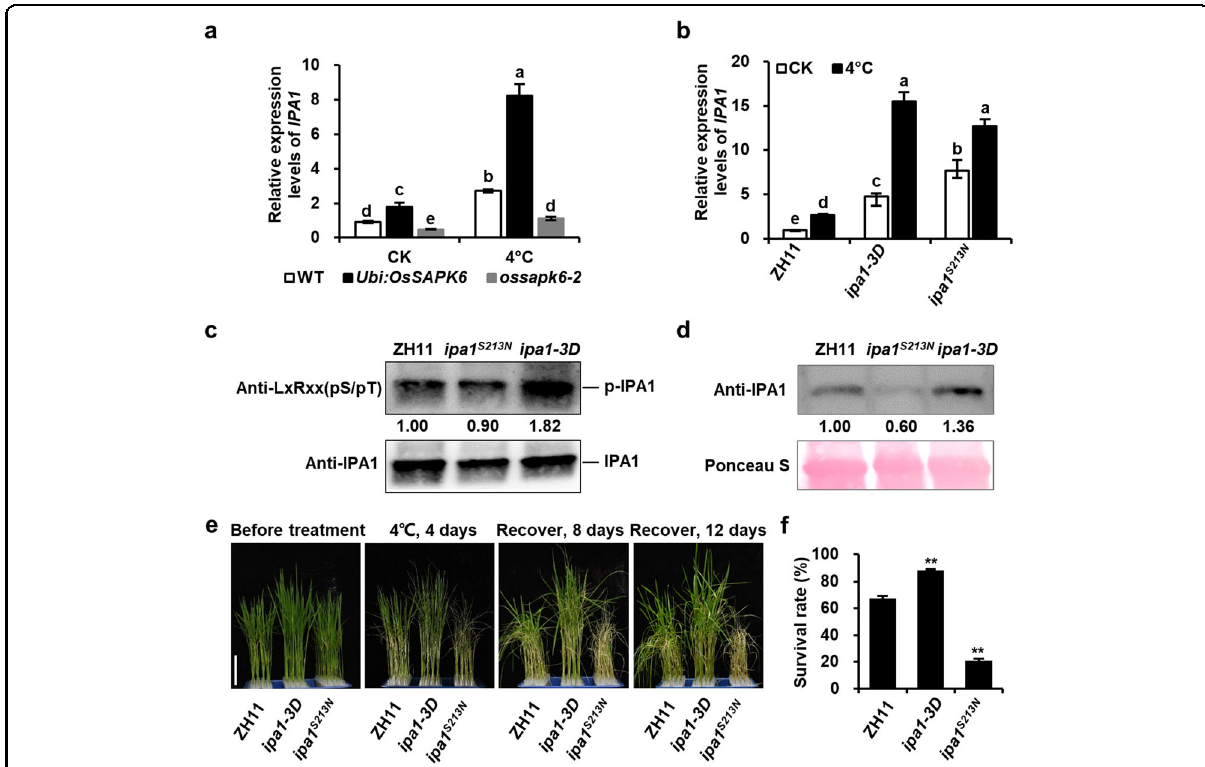
Fig. 5 Phosphorylation of IPA1 is critical for its function in chilling stress responses. a Expression levels of IPA1 in ZH11, Ubi:OsSAPK6 , and ossapk6-2 plants with or without 6 h 4 °C treatment. b IPA1 expression levels in ZH11, ipa1-3D and ipa1 S213N after 4 °C treatment for 6 h. c The phosphorylation of IPA1 in ZH11, ipa1-3D and ipa1 S213N . d IPA1 protein levels in ZH11, ipa1-3D and IPA1 S213N . e Plant morphologies of 2-week-old ZH11, ipa1-3D and ipa1 S213N seedlings before treatment, after 4 °C treatment for 4 days and subsequent recovery for 8 or 12 days. Bars = 5 cm. f Survival rates of ZH11, ipa1-3D and ipa1 S213N after 4 °C treatment as shown in e . Values are means ± SD ( n = 3 biological replicates). In a and b , the different letters indicate signi fi cant differences ( P < 0.01) according to Tukey ’ s honest signi fi cant difference (HSD) test. In f , the asterisks indicate signi fi cant differences compared with ZH11 (** P < 0.01, Student ’ s t -test). See also Supplementary Fig.